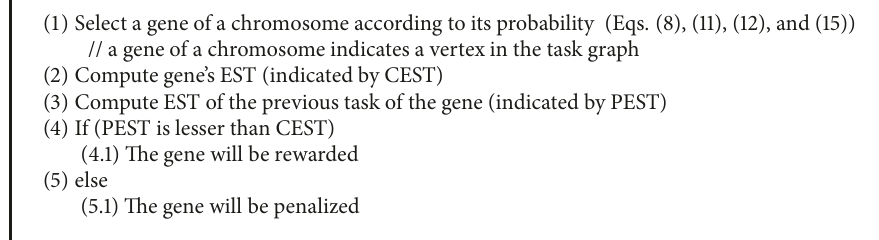
Algorithm 5: Evaluating a selected gene from a chromosome for performing reward and penalty.